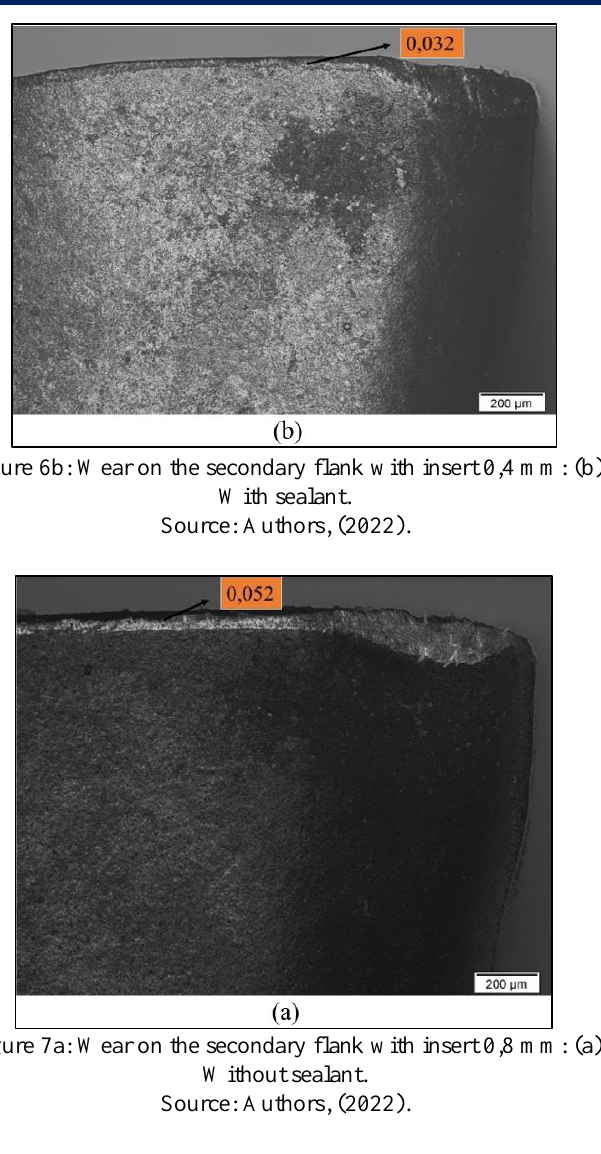
Figure 8b: Wear on the cutting tool rake face with insert 0,4 mm: (b) With sealant.